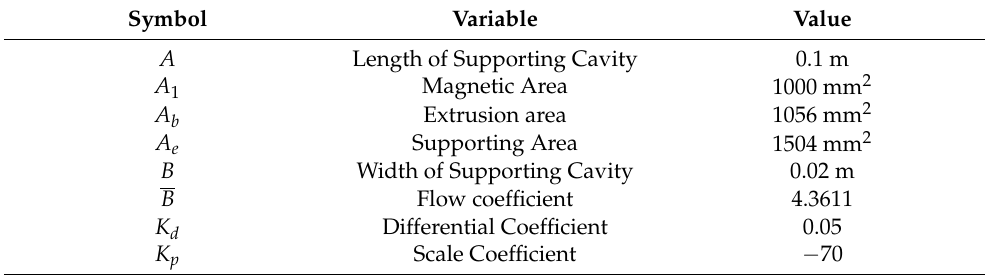
Table 1. Design parameters of